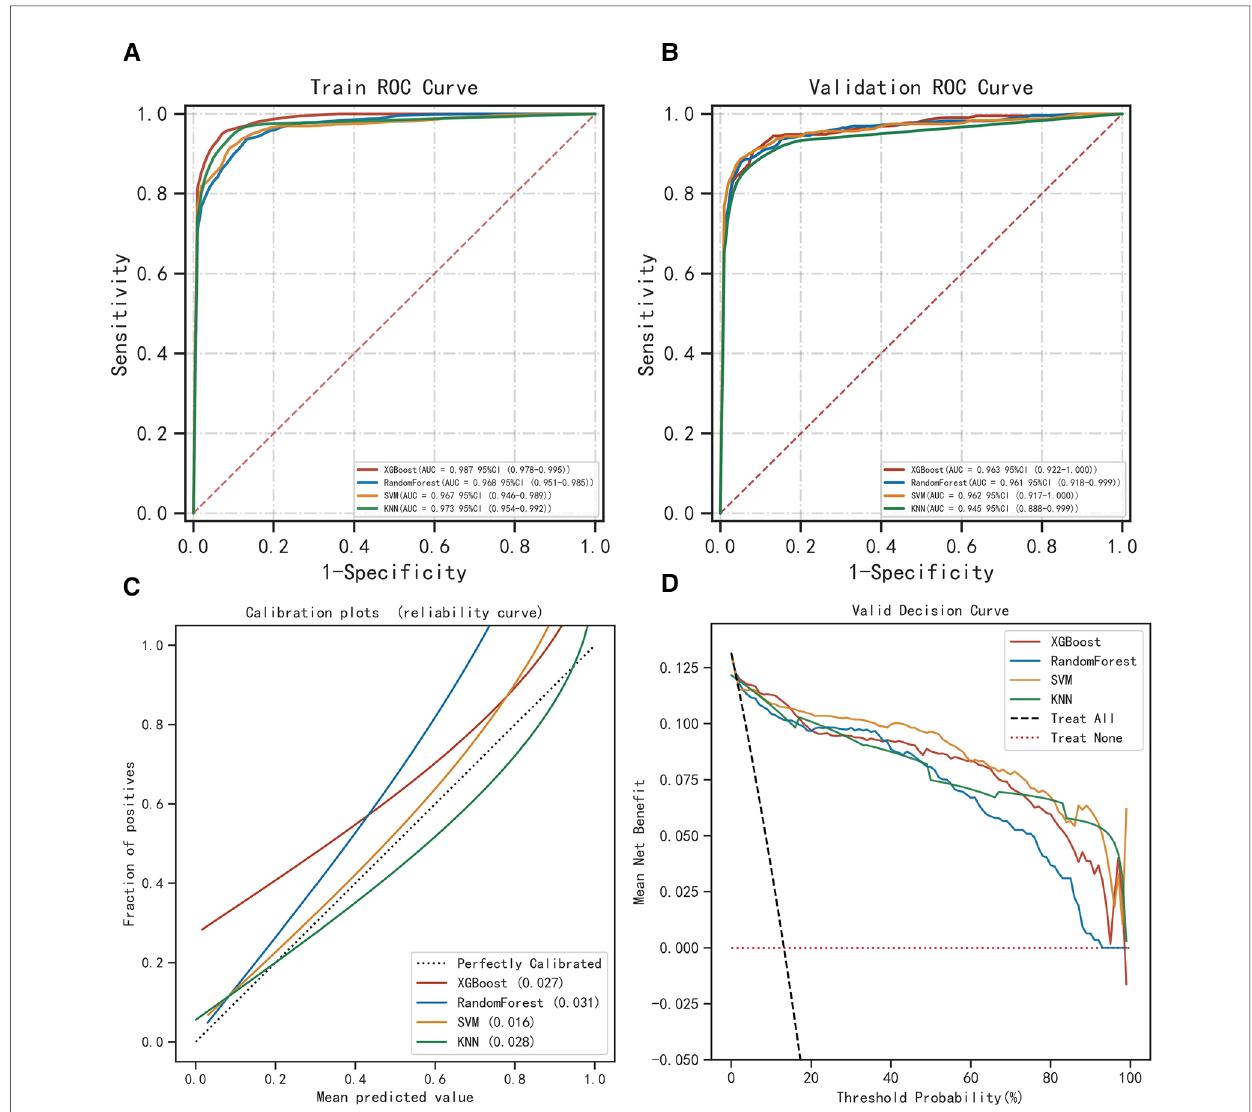
FIGURE 2 Evaluation of the four models for predicting permanent stoma. ( A ) ROC curves for the training set of the four models. ( B ) ROC curves for the validation set of the four models. ( C ) Calibration plots of the four models. The 45° dotted line on each graph represents the perfect match between the observed ( y - axis) and predicted ( x -axis) complication probabilitys. A closer distance between two curves indicates greater accuracy. ( D ) DCA curves of the four models. The intersection of the red curve and the All curve is the starting point, and the intersection of the red curve and the None curve is the node within which the corresponding patients can bene fi t.